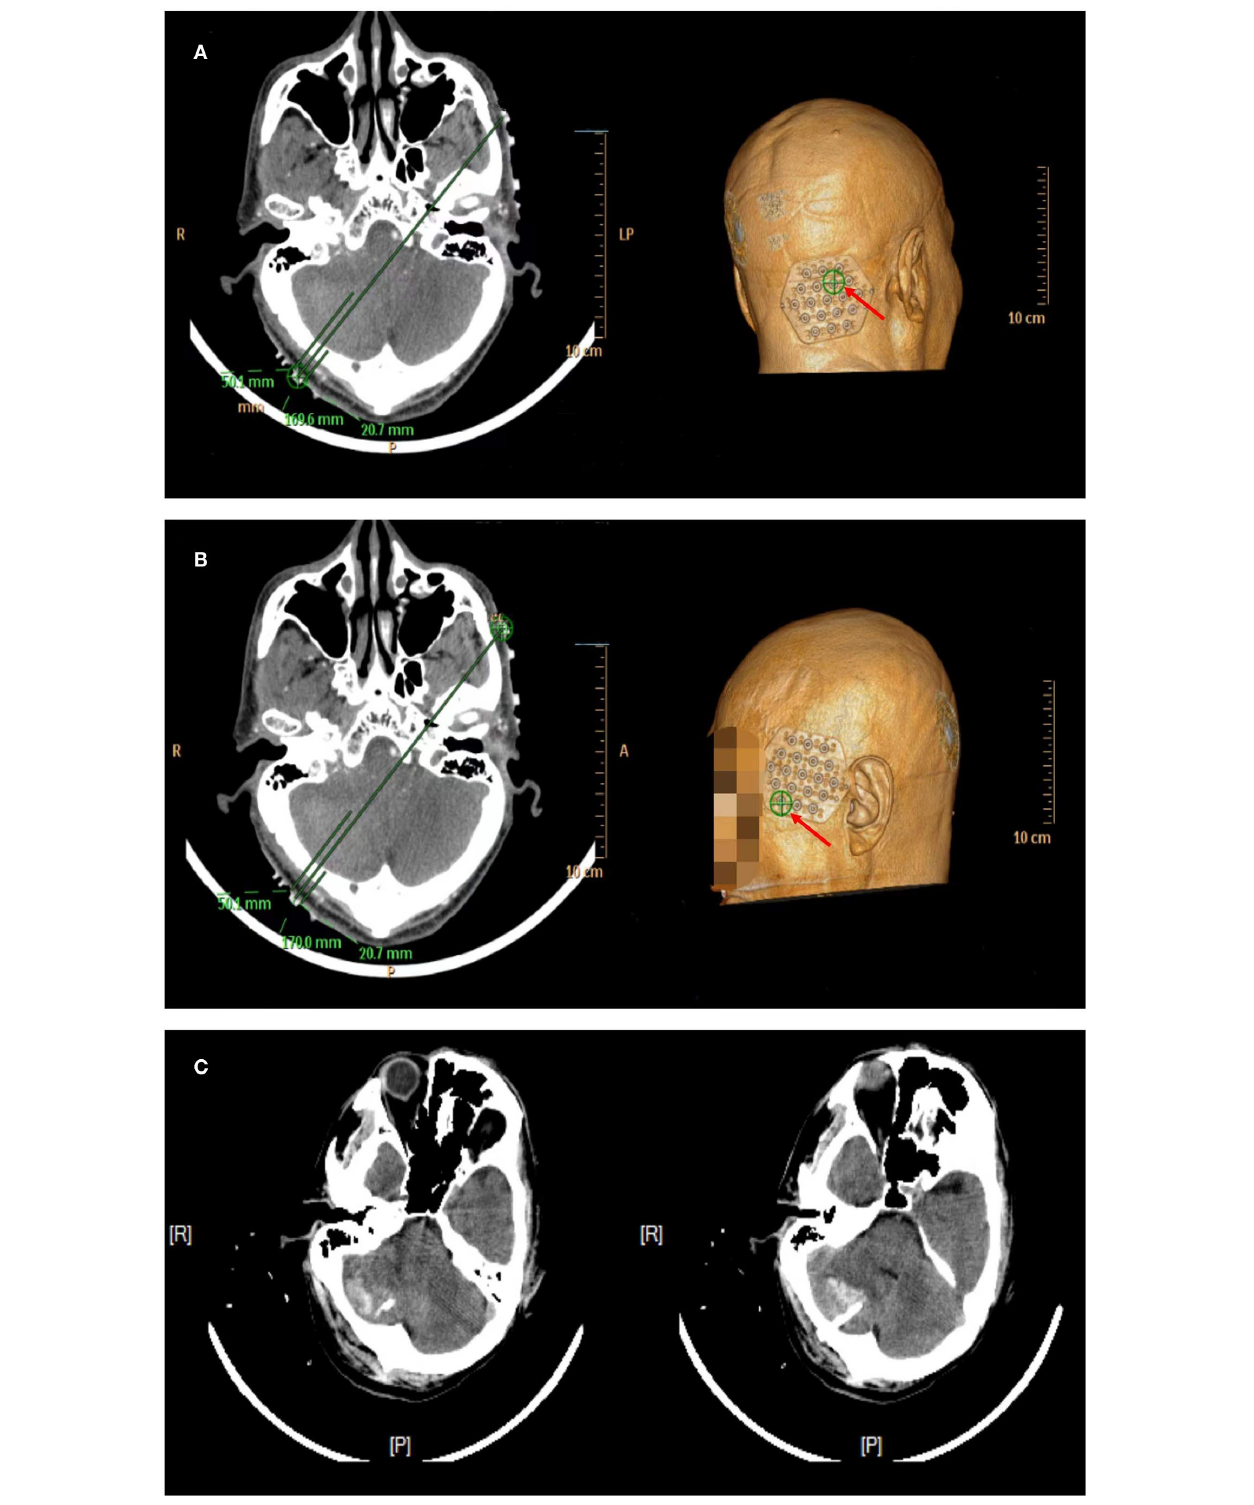
FIGURE 9 | The accurate puncture site, reference point, puncture route, puncture depth (50.1mm), and drill depth (20.7mm) are shown in (A,B) when using the PISP system. (C) shows the good clinical outcomes.